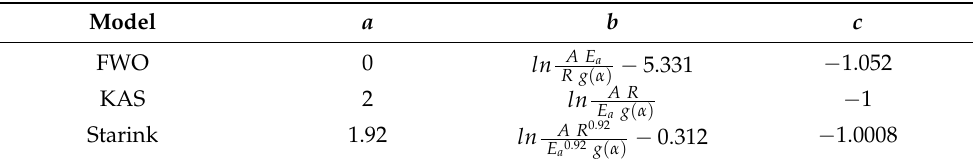
Table 1. Parameters of the generalized form of the isoconversional models.